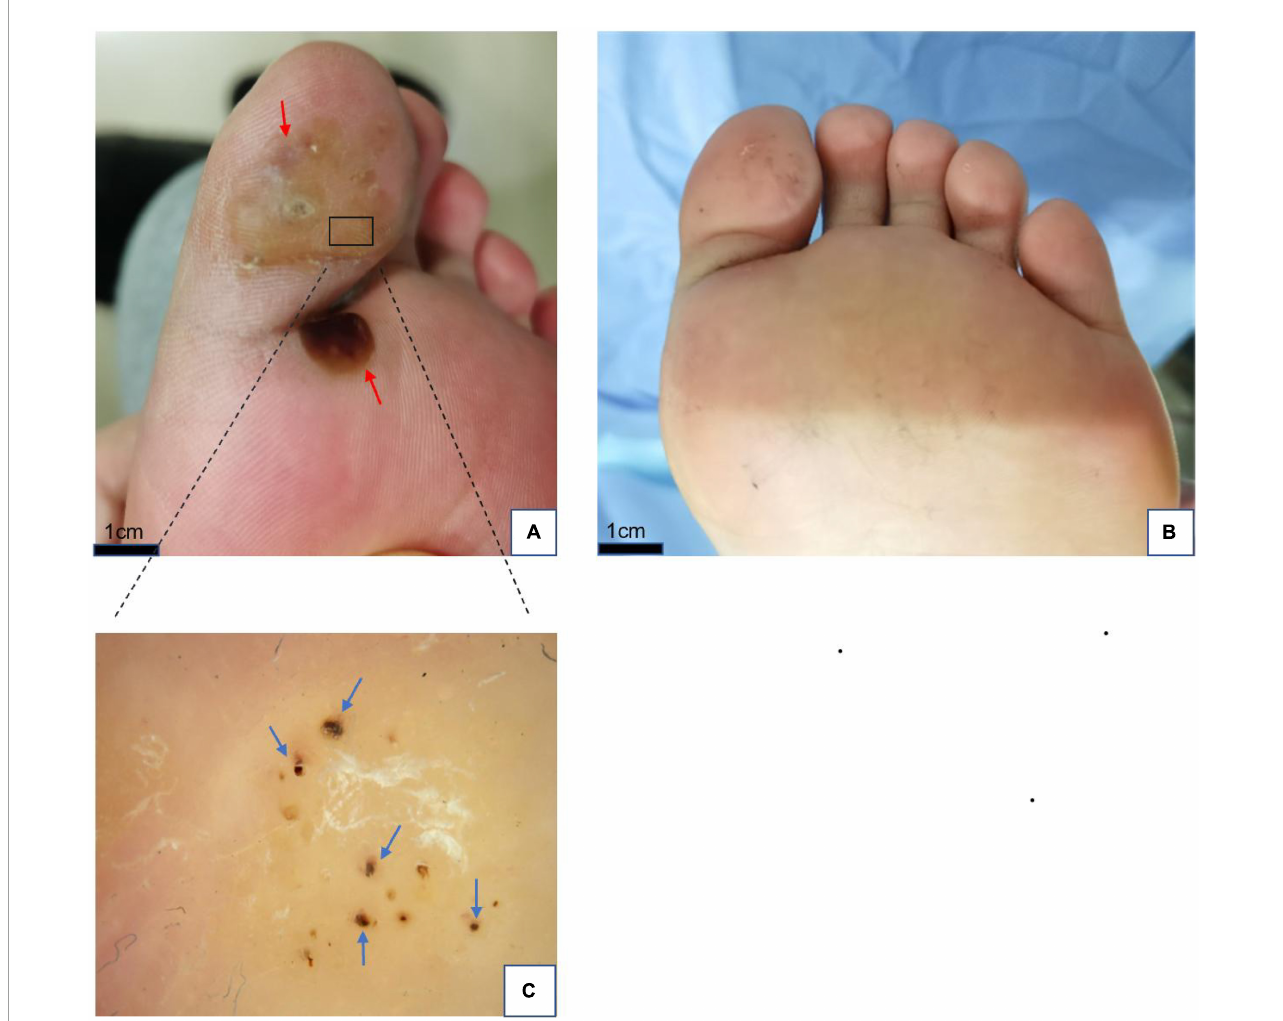
FIGURE2 (A) Plantar warts (red arrows) before treatment. (B) Five weeks after treatment with local hyperthermia (complete resolution). (C) Dermoscopic findings in warts; yellowish structureless with bleeding streaks and spots (blue arrows) on the papilliform surface. Dermoscope 50 ×